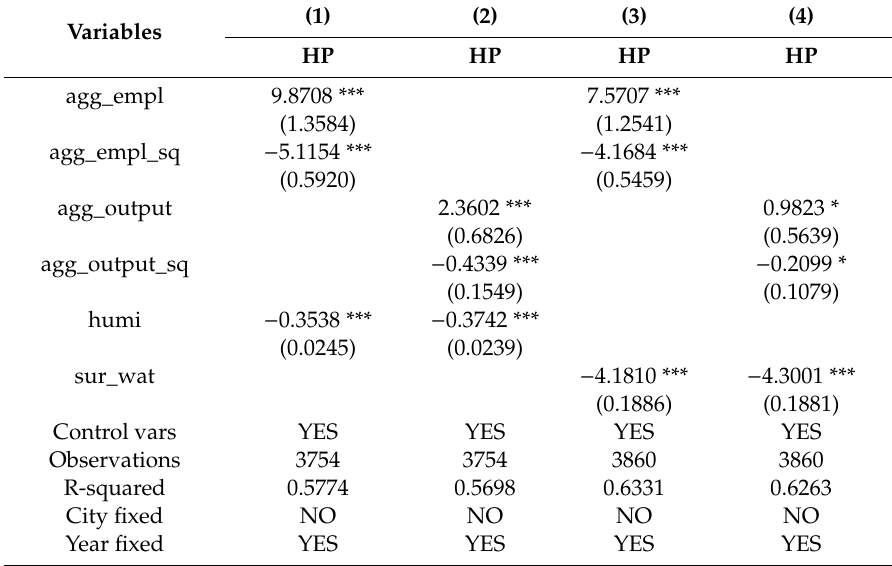
Table A2. Control for humidity and surface water resource.